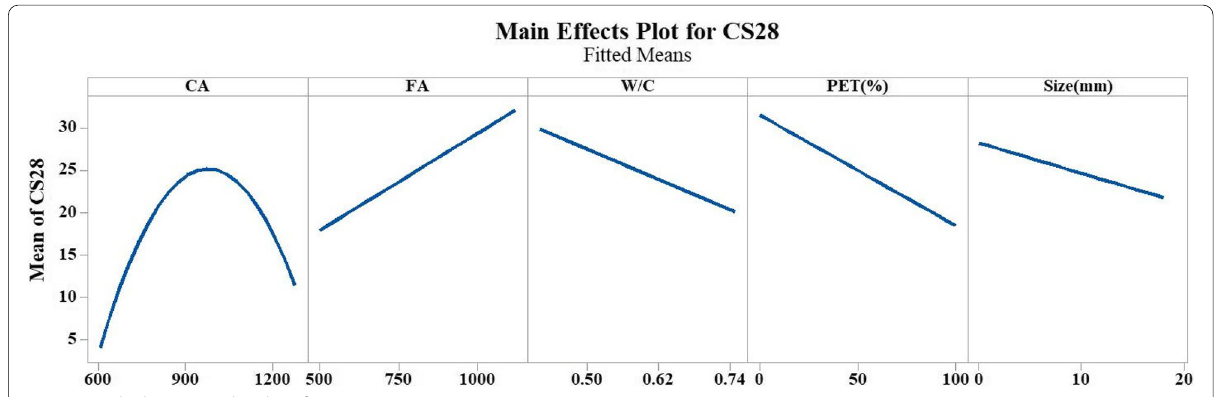
Fig. 3 Residual versus Order Plot of PET-CA